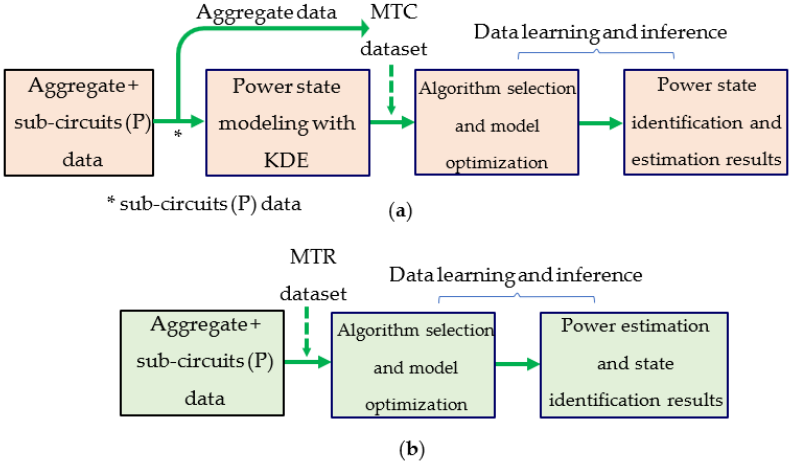
Figure 1. The procedure of experimental design for ( a ) multi-target classification ( b ) multi-target regression approach. regression